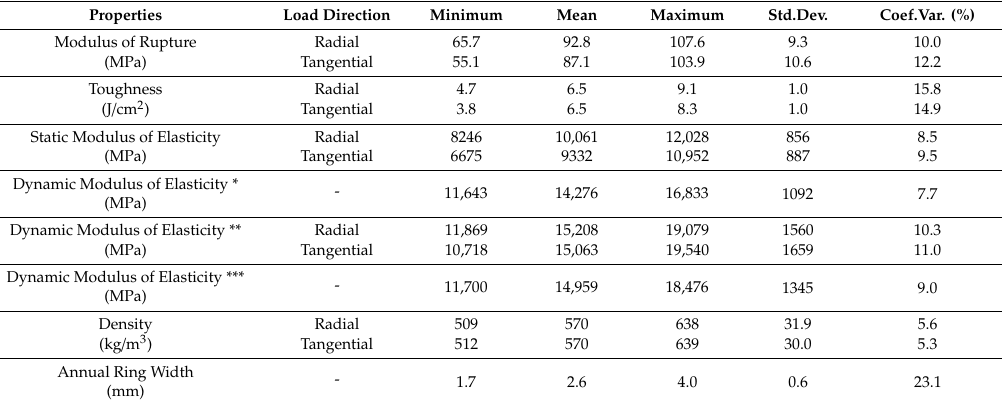
Table 5. Basic Statistical Analyses of the Properties for Linden